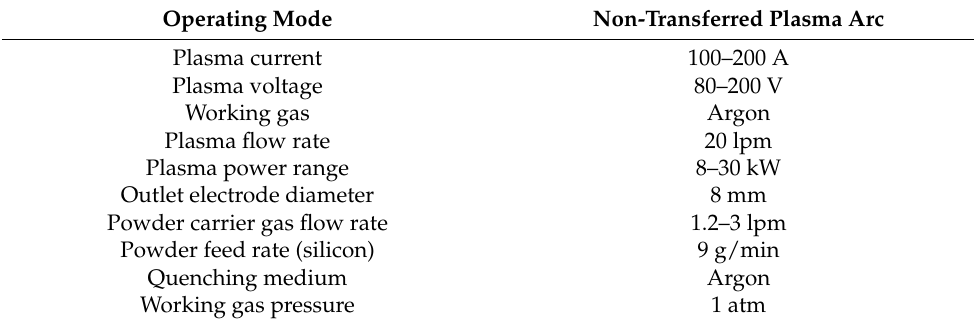
Table 1. Operational parameters used for silicon nanoparticles synthesis.